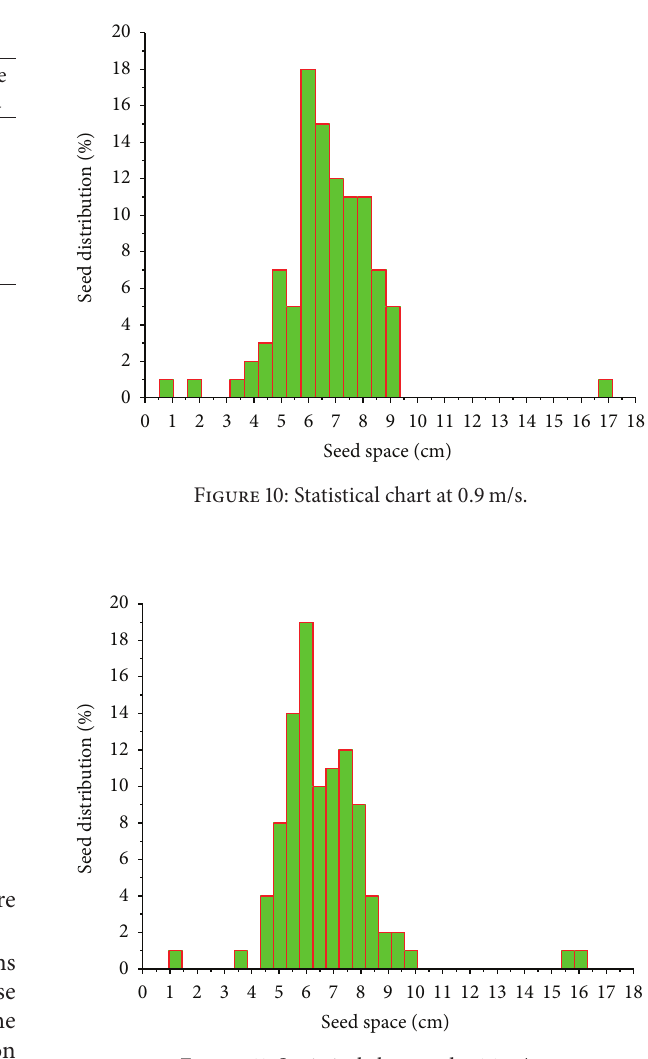
Figure 11: Statistical chart under